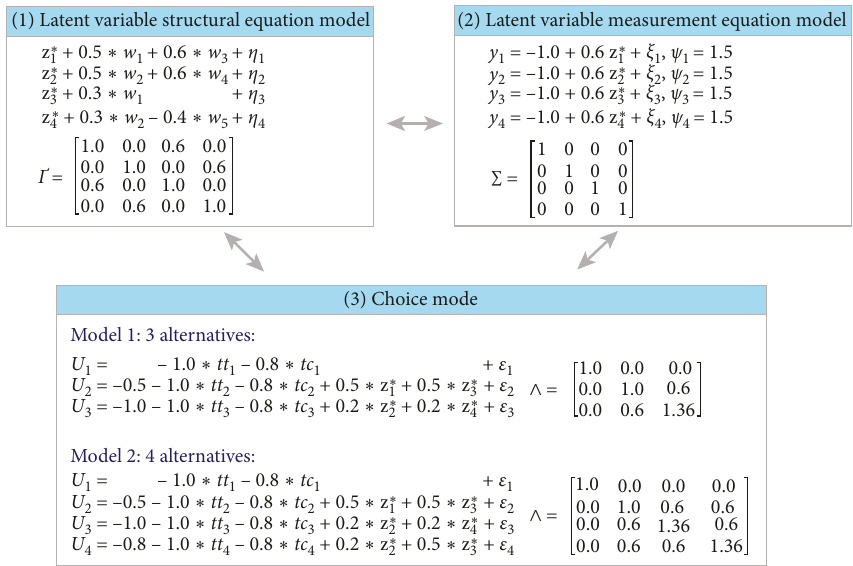
Figure 3: Parameter settings of the ICLV model (for three and four